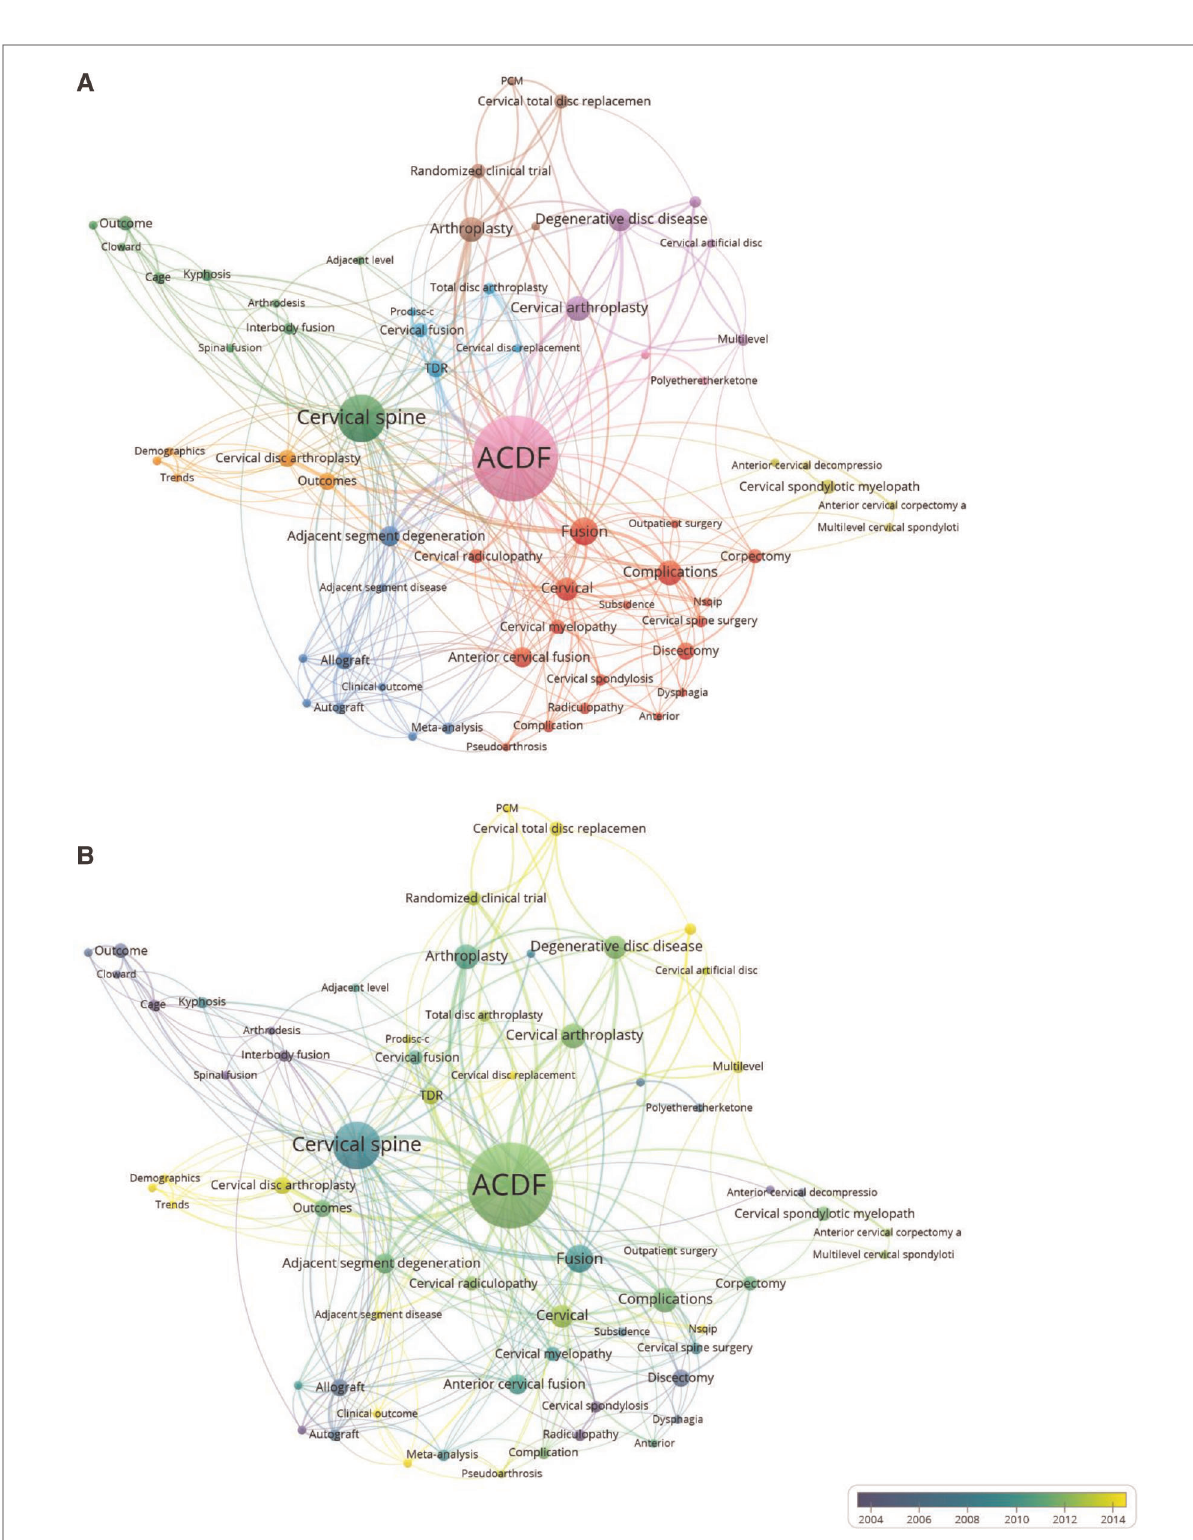
FIGURE 5 Degree of centrality analysis of the author key words of the whole 100 top-cited articles. ( A ) Overlay visualization. ( B ) Time-dependent overlay visualization.